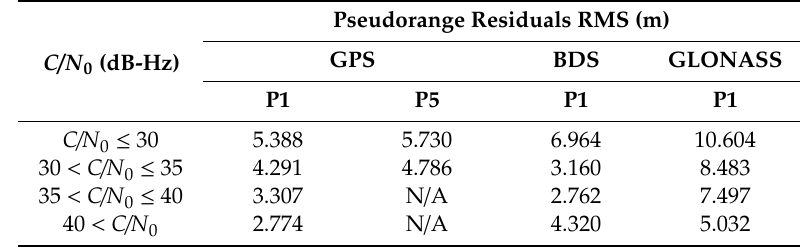
Table 1. Root mean square (RMS) of GPS, BDS, and GLONASS pseudorange residuals of the Huawei Mate30 in di ff erent C / N 0